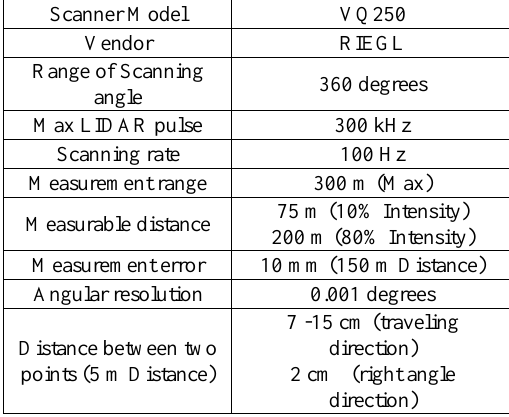
(a) Point clouds on the survey area